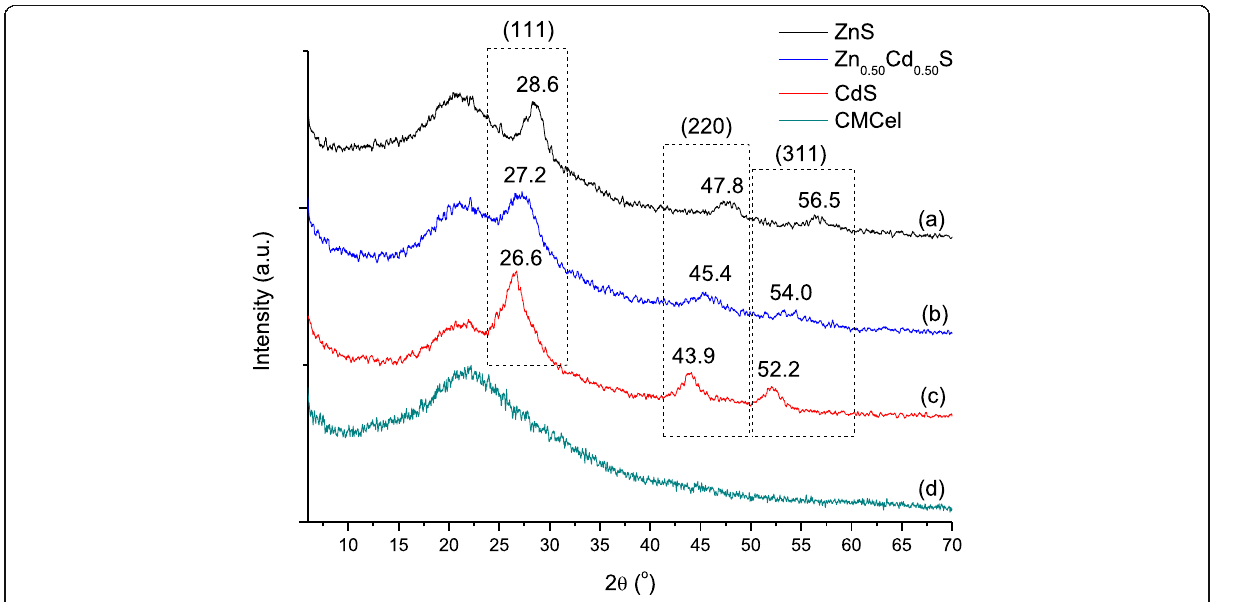
Fig. 3 X-Ray diffraction analysis of conjugates. XRD patterns of ZnS (a) , Zn 0.50 Cd 0.50 S (b) , CdS (c) , and CMCel ligand